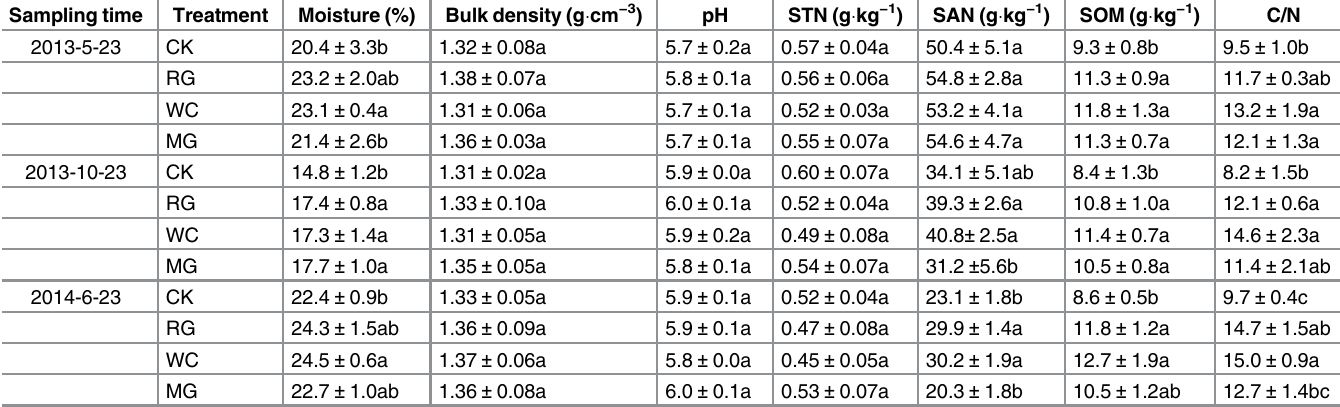
Table 2. Soil properties at the 5 – 10-cm depth at the three sampling time points with and without mulching treatments. Sampling time